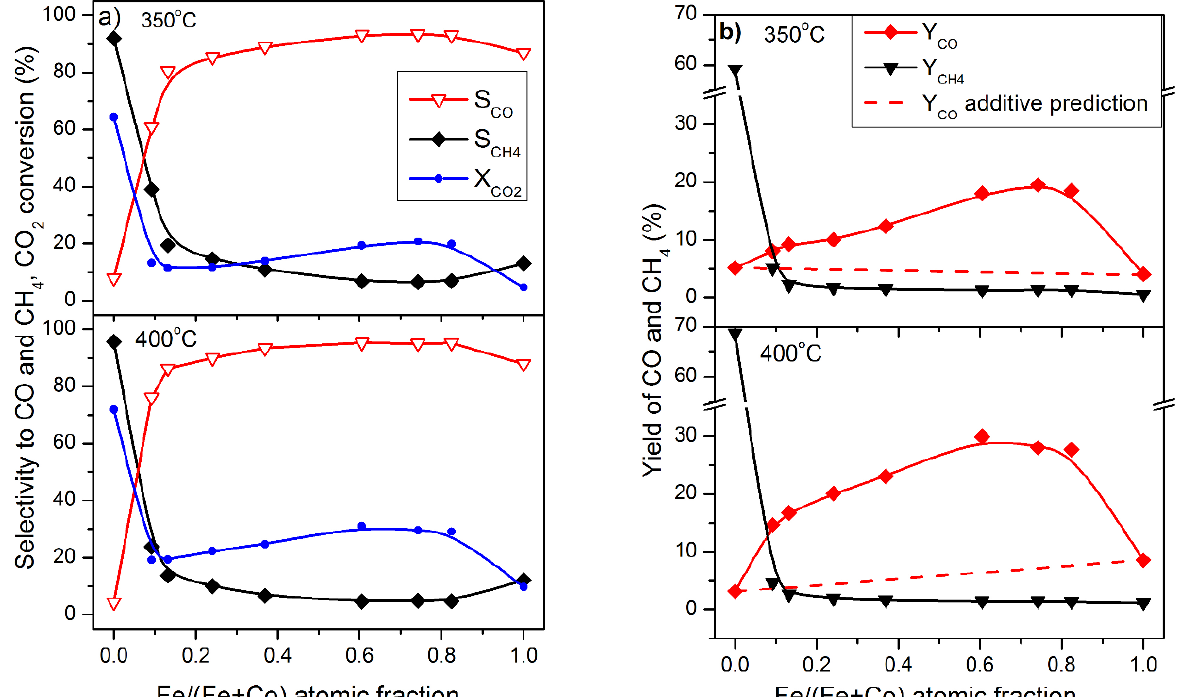
Figure 8. Catalytic performance of Fe–Co thin films in CO 2 hydrogenation a function of Fe/(Fe + Co) atomic fraction in terms of: ( a ) selectivity to CO and CH 4 , CO 2 conversion; ( b ) yield of CO and CH 4 production. Reaction conditions: H 2 /CO 2 = 4/1; 25 sccm, amount of catalyst 0.7 g (38 cm 2 ).